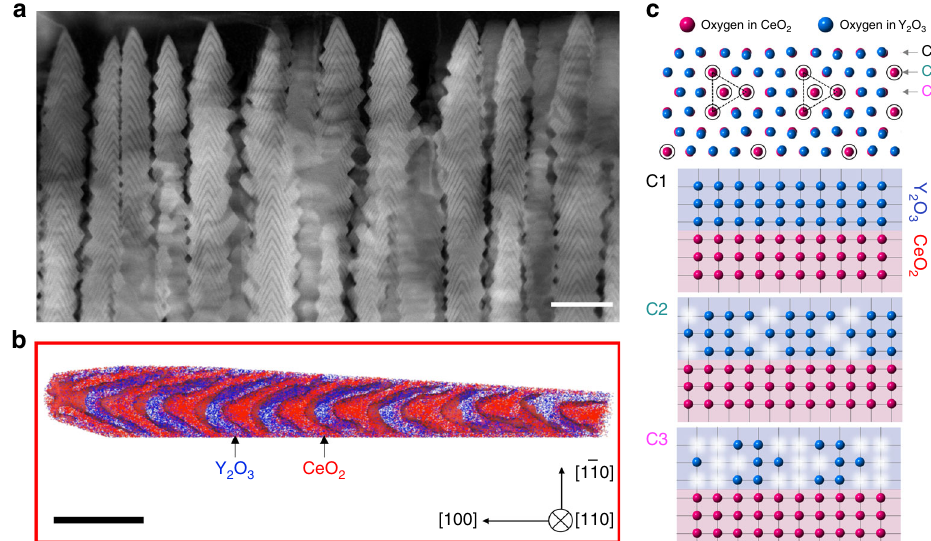
Fig. 1 CeO 2 /Y 2 O 3 nanobrush and the atomic con fi gurations of the (111) interface. a A cross-sectional HAADF-STEM image of a [(CeO 2 ) 6 u.c. /(Y 2 O 3 ) 2 u.c. ] 200 nanobrush superlattice with a thickness of 1.4 μ m grown on a (001) YSZ-buffered silicon substrate, taken along the [110] direction. Because of the nonuniform thickness of sublayers originating from faceting, we use the average thickness of the individual layers. Note that oxide nanostructures were grown on (001) YSZ-buffered silicon substrates, as TEM imaging for samples grown directly on YSZ was dif fi cult because of severe charging of electrons. The scale bar corresponds to 50 nm. b Atom probe tomography (APT) reconstruction with Ce and Y atoms displayed as red and blue points, respectively, showing a three-dimensional view of the free-standing [(CeO 2 ) 6 u.c. /(Y 2 O 3 ) 2 u.c. ] 200 internal structure. The scale bar corresponds to 20 nm. c Schematic of a (111) interface between CeO 2 ( fl uorite) and Y 2 O 3 (bixbyite), in which red and blue circles represent oxygen atoms in CeO 2 and Y 2 O 3 , respectively. Cations are not shown. The (111) Y 2 O 3 /CeO 2 interface is a combination of three different anion arrays, C1, C2, and C3. A cross-section of the C1 array shows a perfect match between numbers of oxygen atoms on interfacing CeO 2 and Y 2 O 3 sides. In contrast, on the Y 2 O 3 side of the interface, a cross- section shows on average one oxygen vacancy every four sites in the C2 array and one oxygen vacancy every two sites in the C3